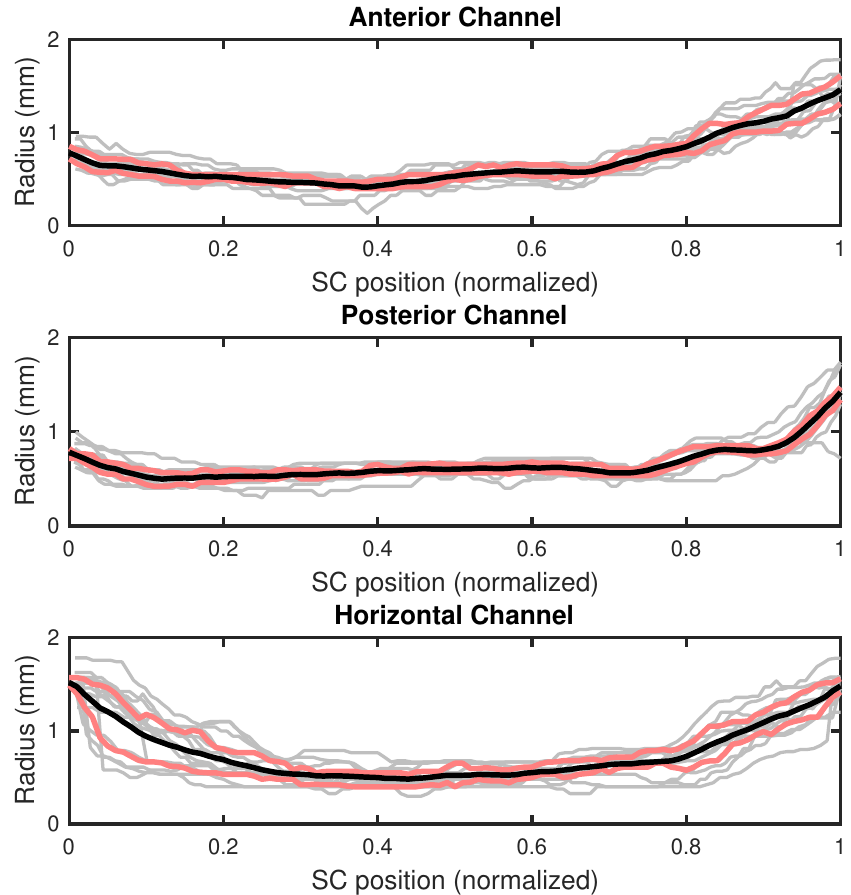
Figure 4. Dependence of the canal radius on the normalized position according to the results obtained with the proposed skeletonization method: ( top ) the ASC radius for all studied volunteers, where the black thick line represents the mean value, and the red lines the percentiles 25 and 75; and the same procedure is followed for the PSC ( middle ) and the HSC ( bottom ). The ampular ends are located on the right (for a position 1) and the non-ampular on the